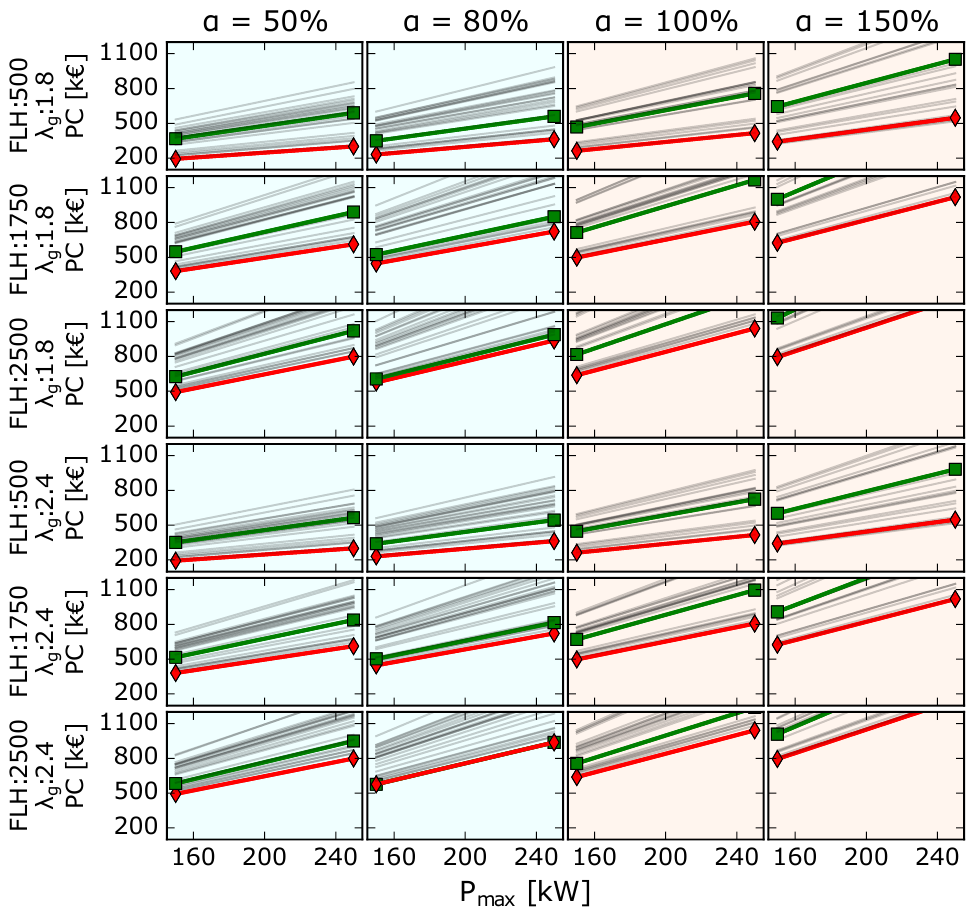
Figure 4. Present Cost (PC) of HVAC scenarios ( Geo-Sce ) containing only one heat and one cold production system, each coupled to its own emission system for the different parameter values of Table 4. The blue backgrounds indicate that borefield of the Geo-Sce is heating dominated (more energy extracted than injected). The lines representing GEOTABS-M-Sce are plotted in green with square markers and the lines referring to the most conventional scenario type ( Conv-M-Sce ) are plotted in red with diamond markers.